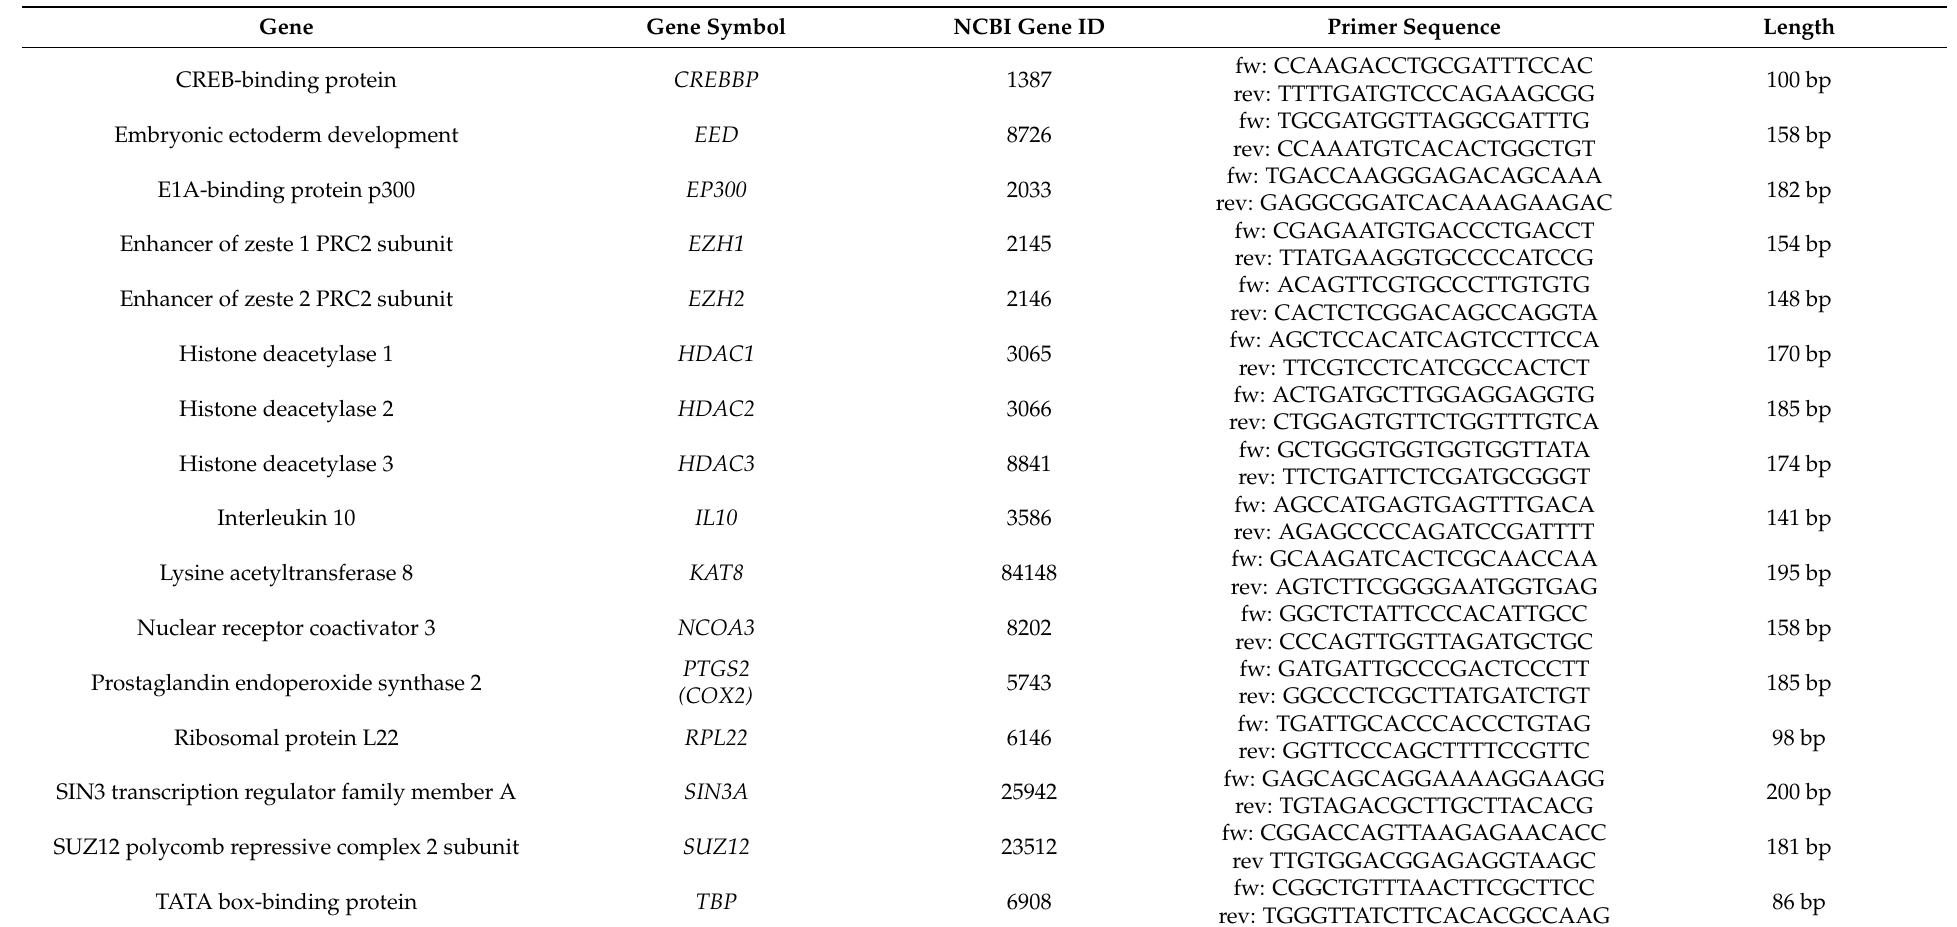
Table 1. qPCR primer sequences of human genes indicated in the 5 (cid:48) -3 (cid:48) direction. bp, base pairs; fw, forward; Length, amplicon length; PRC, polycomb repressive complex; rev,